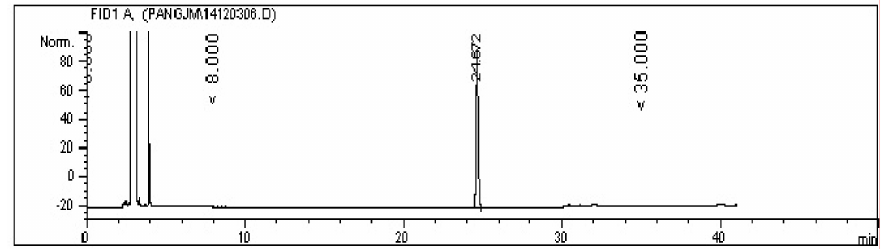
Figure 4. The GC spectrum of Hou.